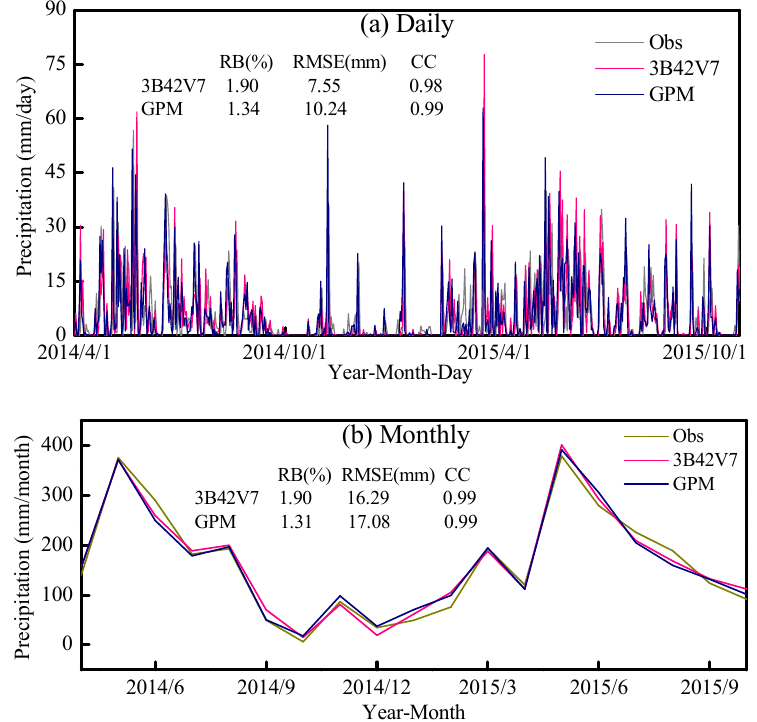
Figure 5. The precipitation time series from GPM and rain gauges in the Ganjiang River basin from May 2014 to October 2015 (a, Daily; b, Monthly).